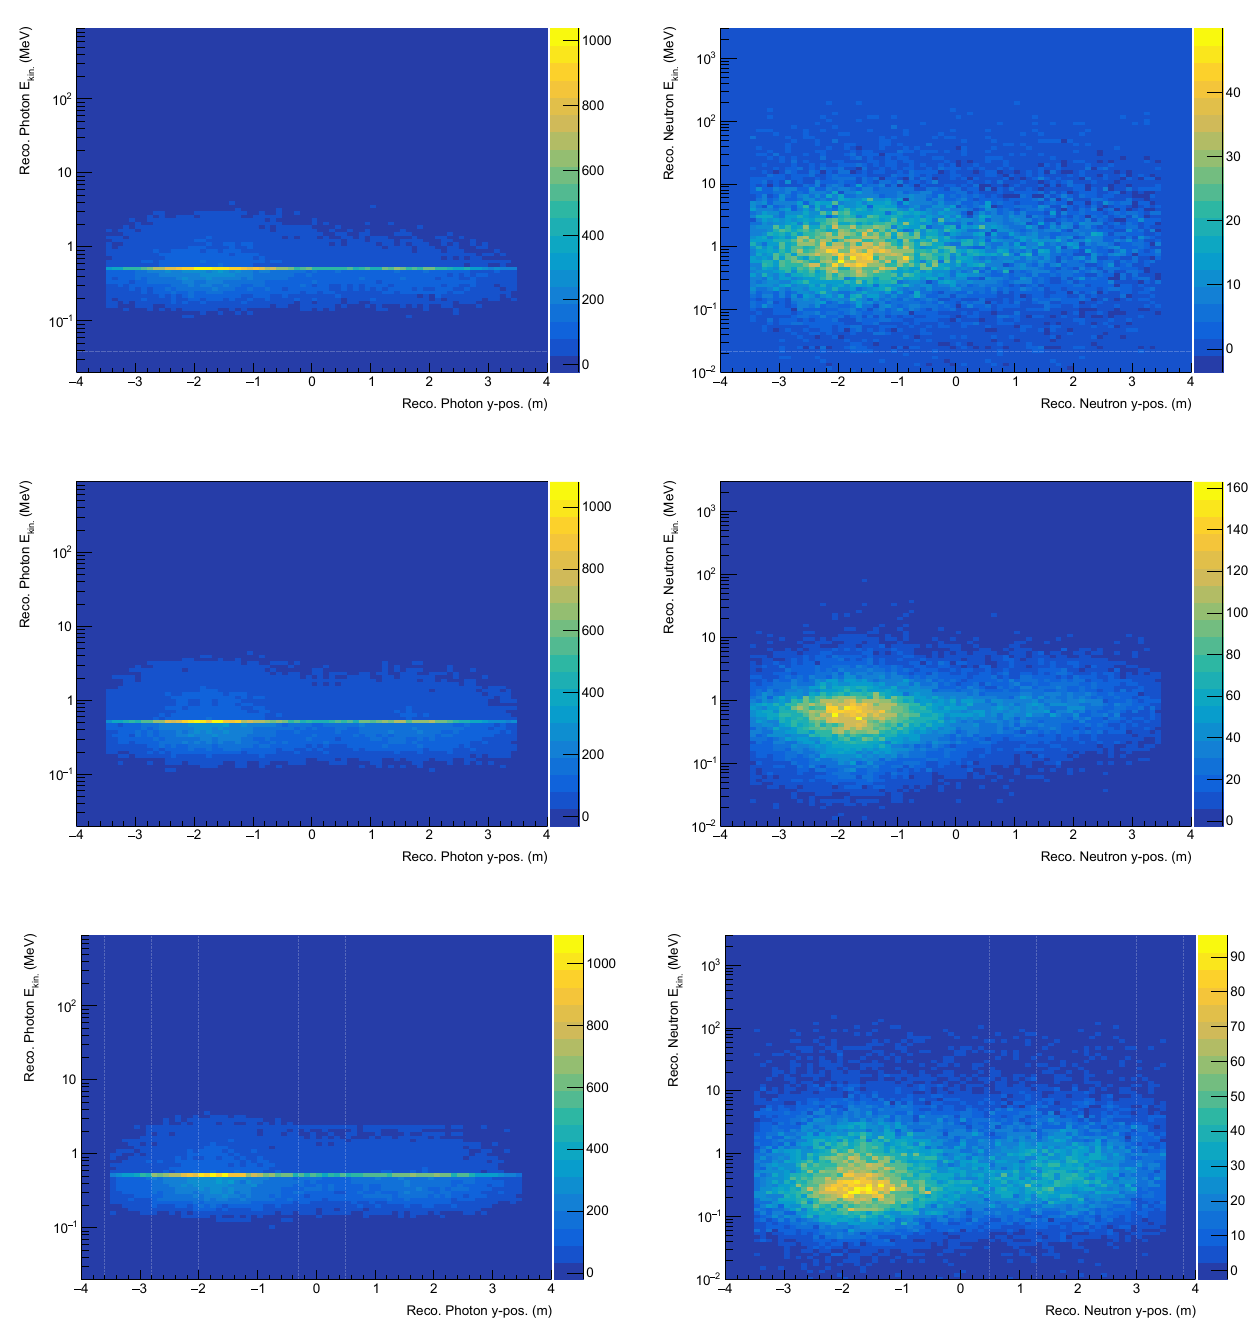
Figure 2. The distribution of the kinetic energy E kin . as a function of the y -position of the reconstructed photons ( left column ) and neutrons ( right column ) in the upper detector plane. The materials analyzed are Cesium ( upper row ), Tin ( middle row ) and Palladium ( bottom row ). The hits from the empty container are